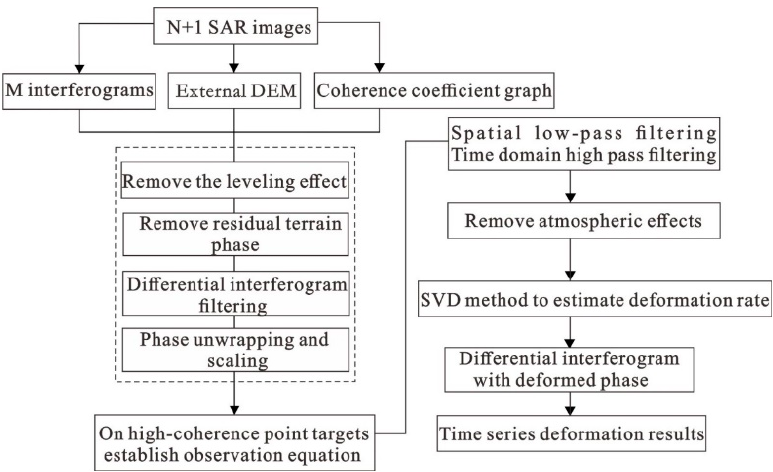
Figure 4. Processing flow of SBAS-InSAR data (After Berardino, 2002 [17]).